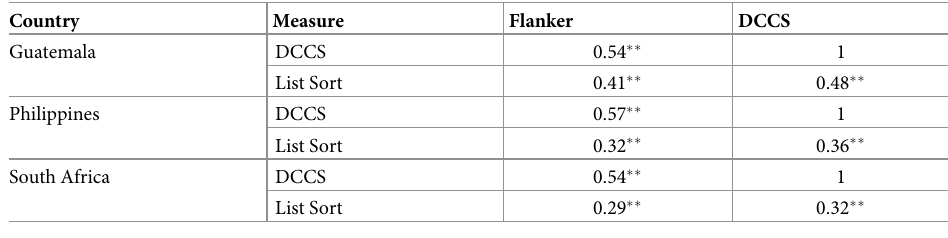
Table 2. Correlations between each measure across each site.